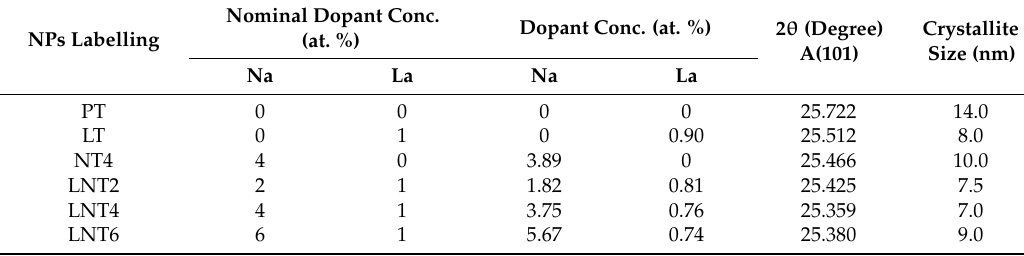
Table 1. Nominal & actual dopant concentration, 2 θ values and crystallite size of NPs. NPs